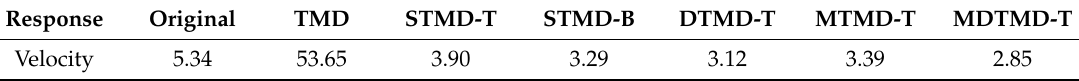
Figure 14. Velocity time history curves of structure under di ff erent TMD control strategies: ( a ) at di ff erent TMD positions of the same control strategy and ( b ) under di ff erent TMD control strategies. Table 5. Peak velocity response of control strategies under simple harmonic load (10 − 2 m / s).